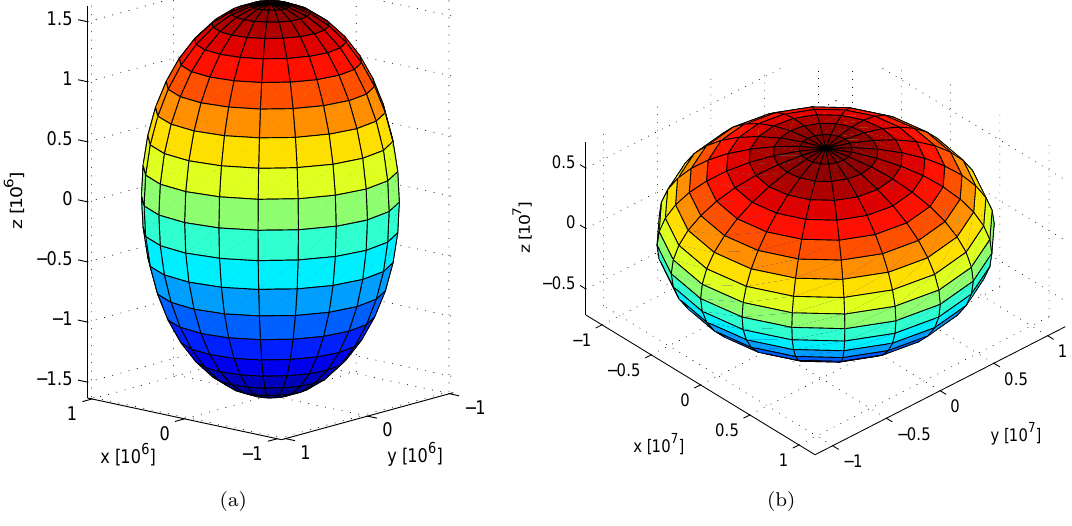
Figure 8: Graphical representation of the SPM stiffness ellipsoid with θ = 0: (a) σ r ; (b) σ t